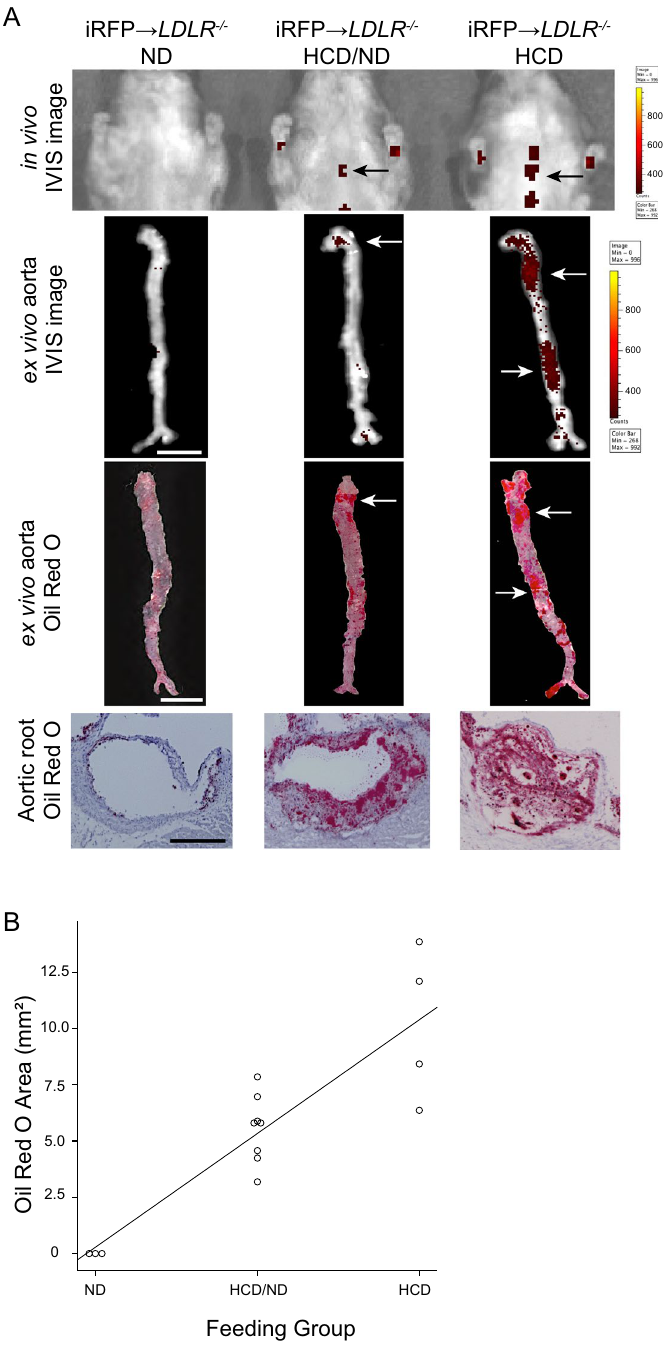
Figure 4. iRFP imaging system enables the observation of the differences in macrophage-rich plaque burden in vivo . The iRFP → LDLR − / − mice were fed with different HCD quantities for 8 weeks to induce different atherosclerosis plaque burdens. The “ND group” was fed the ND for entire experimental period, the “HCD/ND group” was fed the HCD and ND on alternating weeks, and the “HCD group” was fed the HCD for the entire experimental period. ( A ) In vivo IVIS images, ex vivo aorta IVIS images (scale bar, 5 mm, signal-positive areas are marked by arrows), same aortas stained with ORO (scale bar, 5 mm, ORO-positive areas are marked by arrows), and aortic root sections stained with ORO (scale bar, 100 µ m). ( B ) ORO-positive areas after 8 weeks of induction plotted against the feeding group. The ORO-stained areas showed a positive correlation with the feeding group at the P = 0.01 level. The data are from one representative experiment of at least two independent